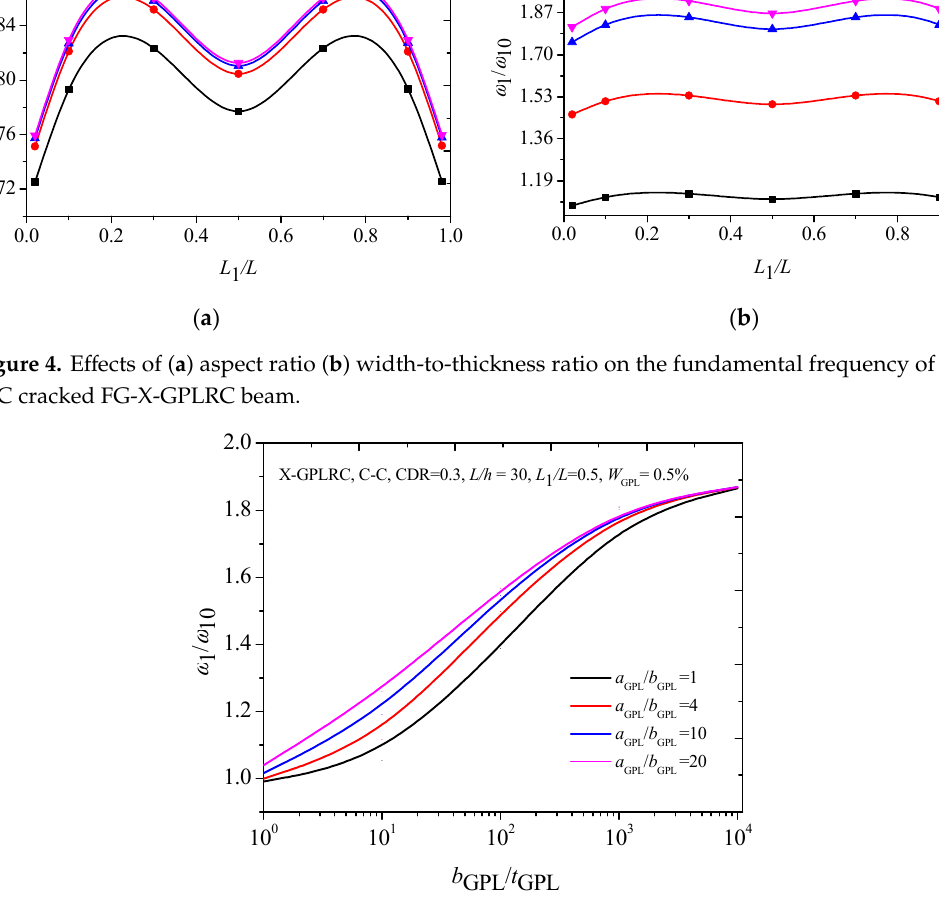
Table 4. Dimensionless fundamental frequencies ω 1 / ω 10 of cracked FG-X-GPLRC beams with di ff